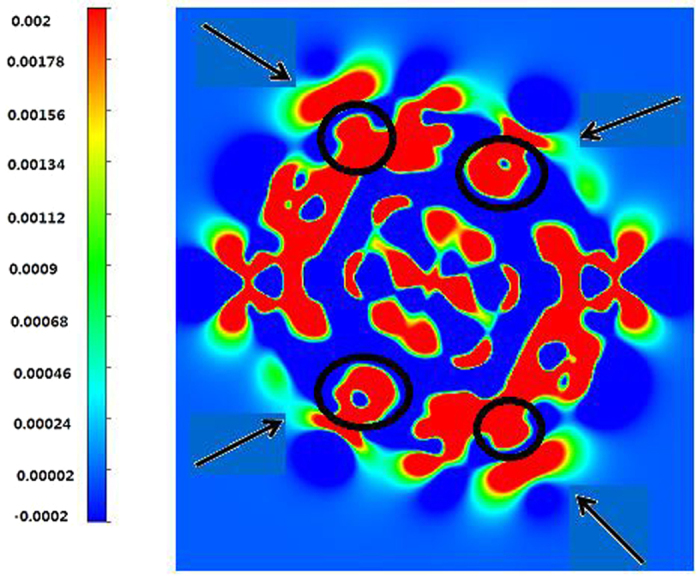
Plot of the 2D electron density difference for W13@Pt42.